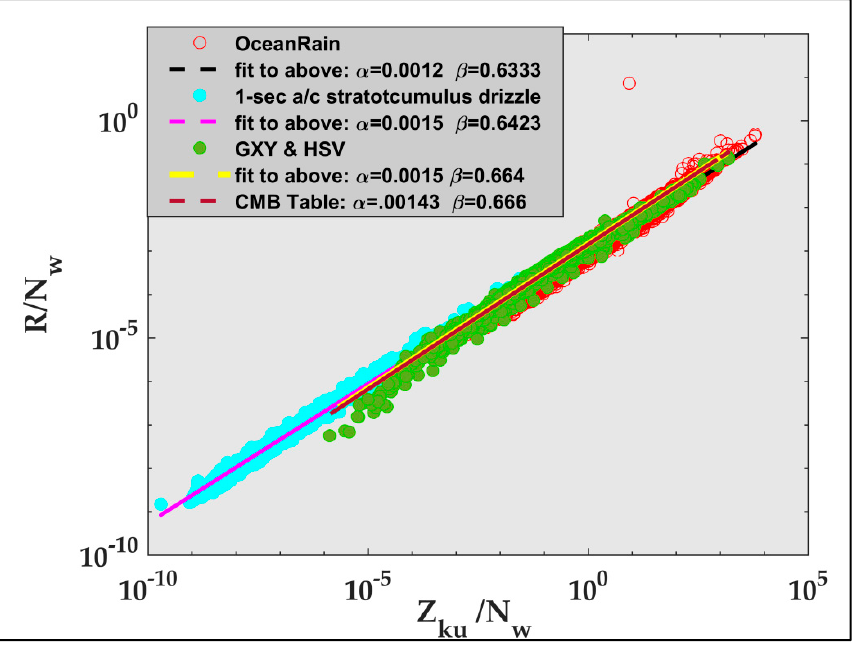
Figure 10. Variation of the rain rate (R in mm h − 1 ) normalized by N W (in mm − 1 m − 3 ) versus Ku-band reflectivity (Z ku , in mm 6 m − 3 ). See legend, which lists the regimes.